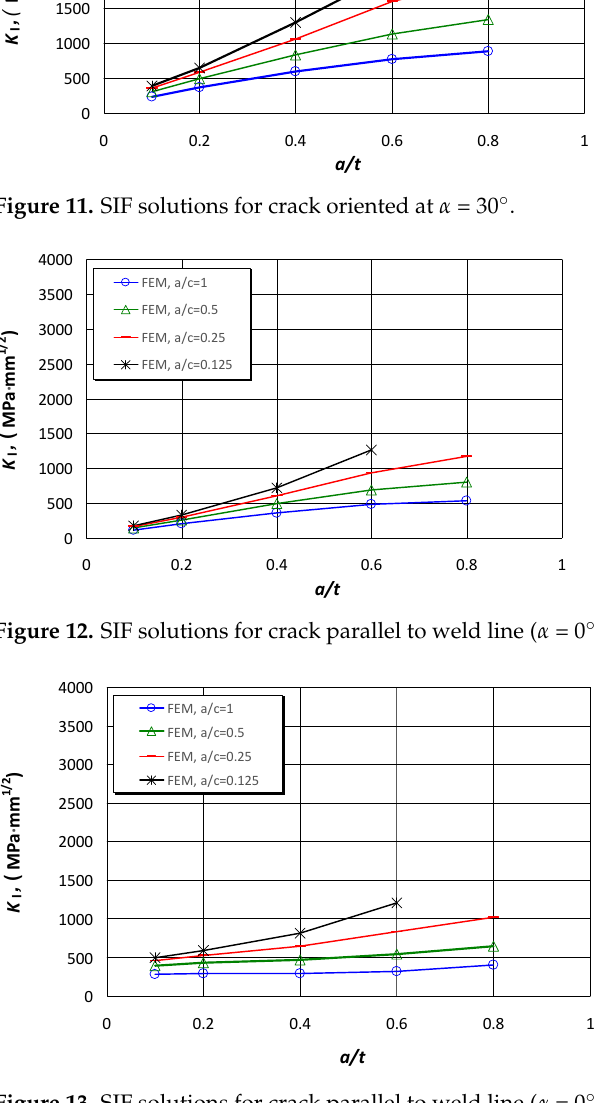
Figure 13. SIF solutions for crack parallel to weld line ( α = 0°) at η = 22 mm (Figure 4).